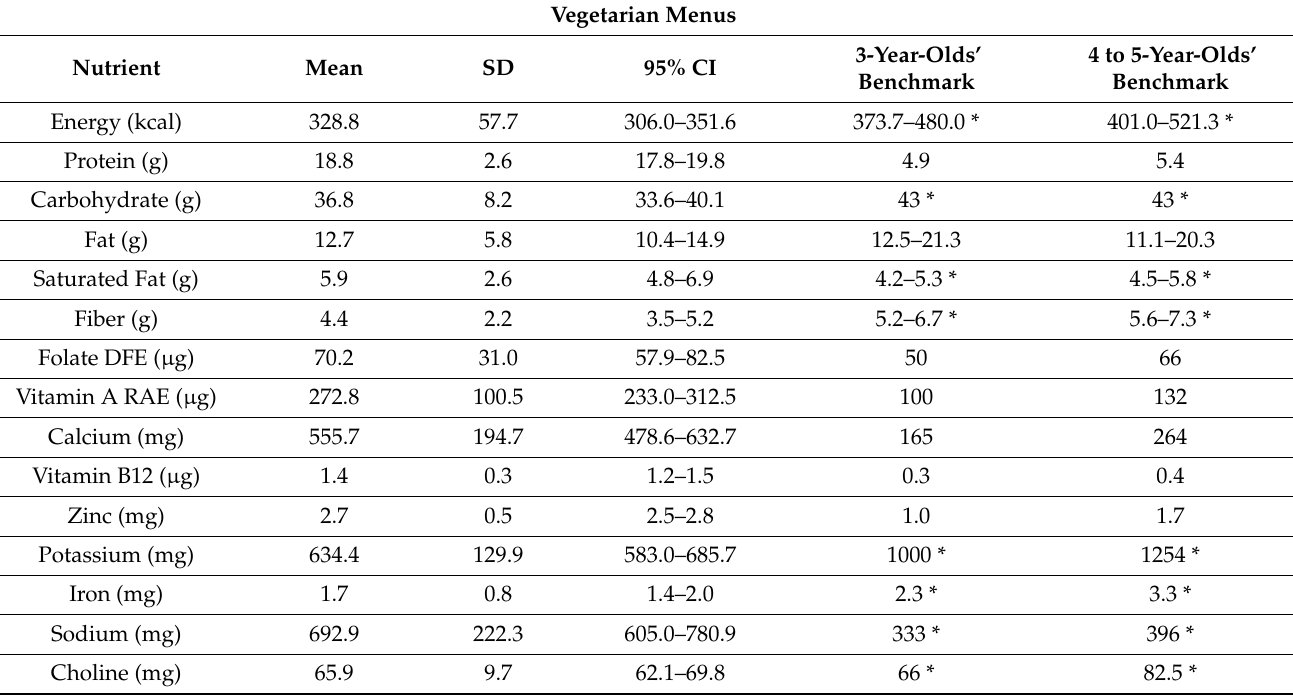
Table 4. Nutritional adequacy of the vegetarian